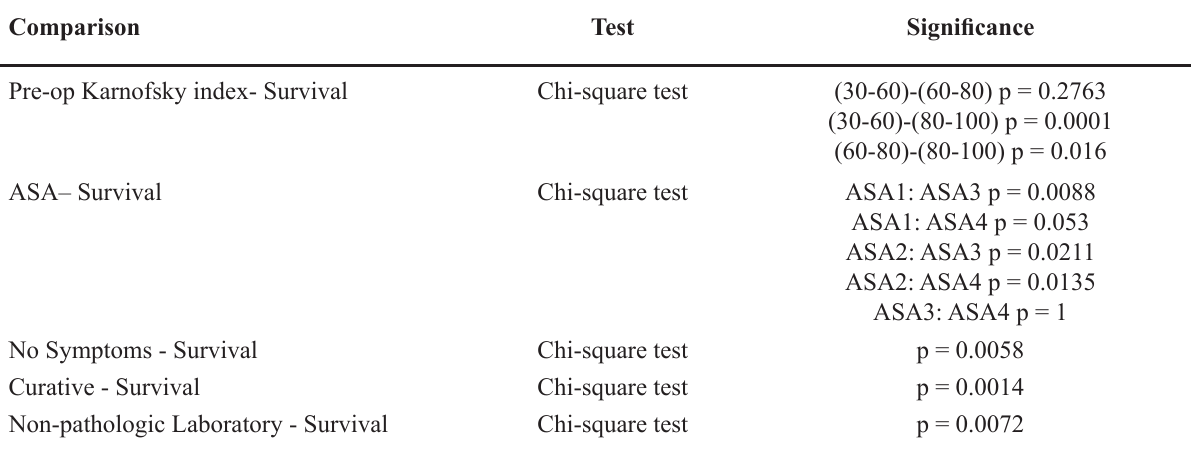
Table 2 – Chi-square test. Preoperative clinical variables that effect patient’s survival are shown in bold letters.